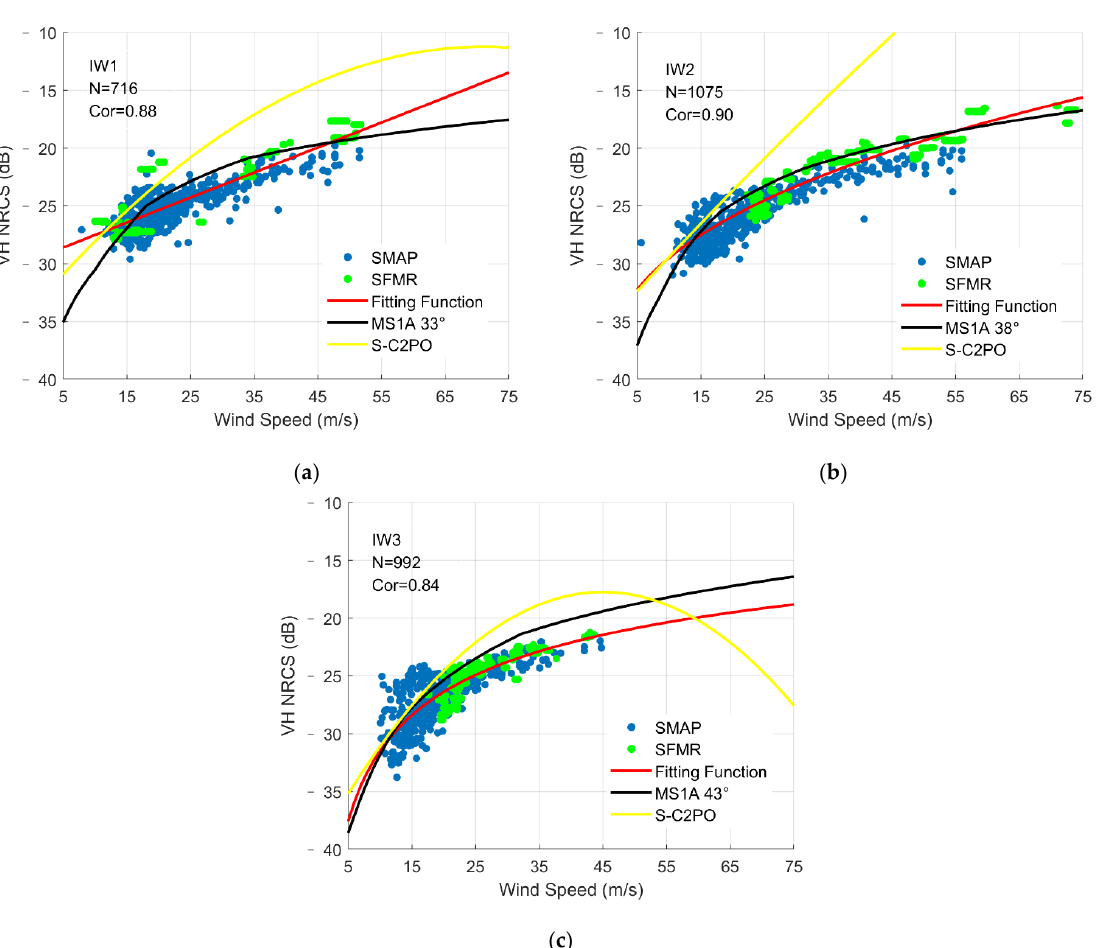
Figure 3. Comparison between VH NRCS and wind speed in ( a ) IW1; ( b ) IW2; ( c ) IW3. Matching points from SMAP and SFMR are colored by blue and green.